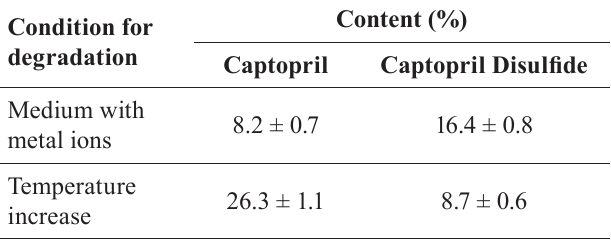
TABLE VII - Remaining concentrations of captopril and disulfide of captopril in the formulation after the